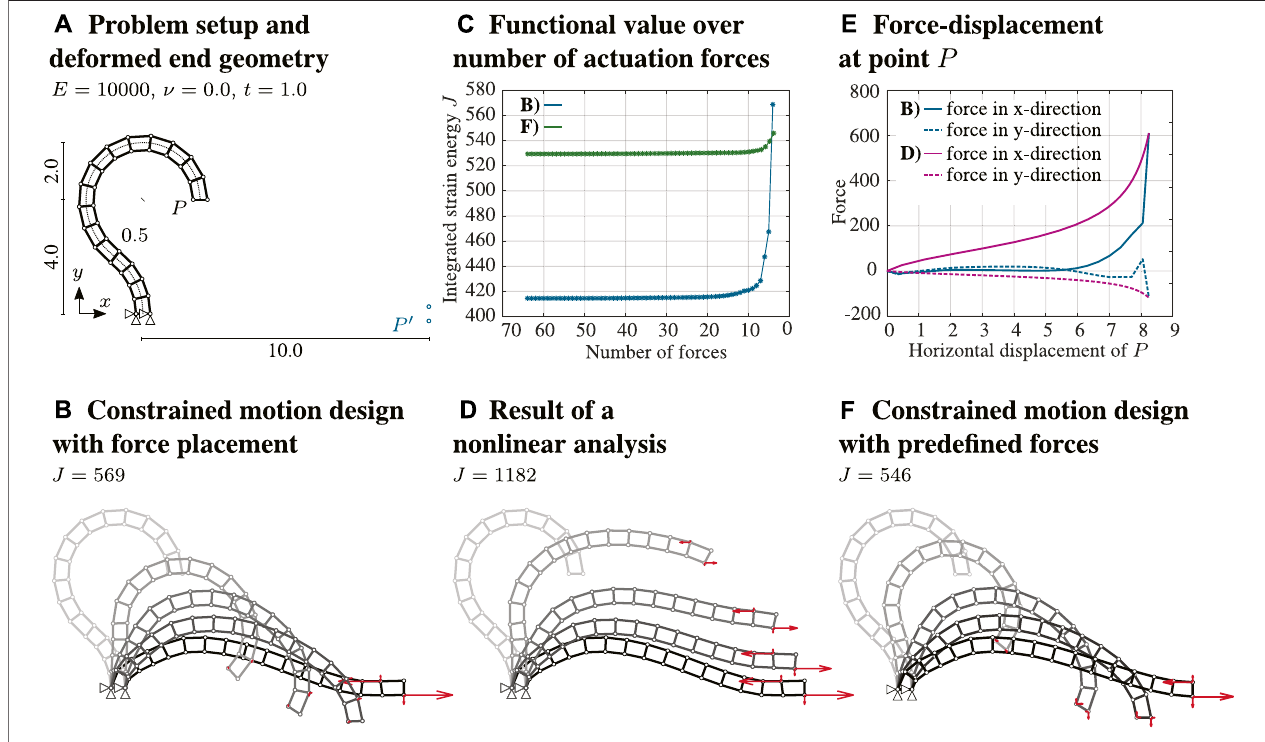
FIGURE 6 | Motion design and actuation force placement for a morphing cantilever. (A) Problem setup amd deformed end geometry. (B) Constrained motion design with force placement. (C) Functional value over number of actuation forces. (D) Result of non-linear analysis. (E) Force displacement point P . (F) Constrained motion design with prede fi ned